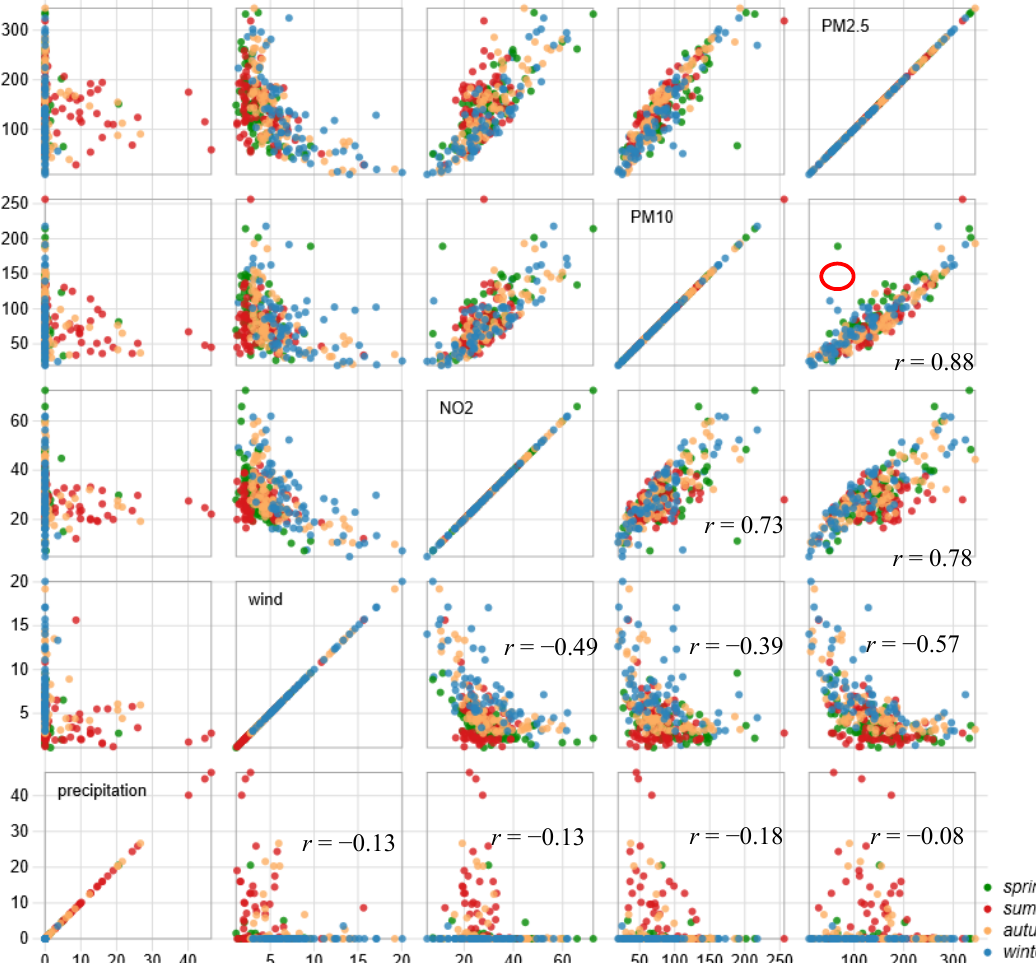
Figure 8. Scatter plots showing relationships among PM 2.5 , PM 10 , NO 2 , wind, and precipitation. Different colors represent four seasons, where r is the correlation coefficient of two factors. Red circle marks a special point that is markedly different from the others.